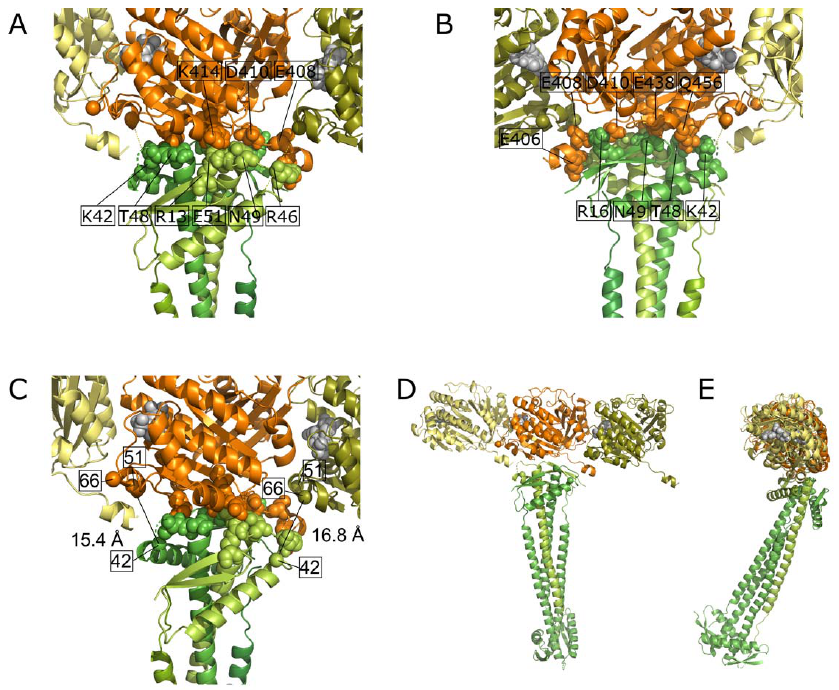
Figure 7. Haddock model of the interaction between a FtsZ filament and the ZapA tetramer. ( A ) and ( B ). Front and back side view of a closeup of the interaction site with the interacting amino acid residues of both proteins indicated. ( C ) Distances between the C α atoms (spheres) of residue K42 of ZapA and residues K51 and K66 of FtsZ that were found to cross-link. ( D ) Front and side view of the interacting proteins. ( E ) Frontal overview of a FtsZ filament consisting of three monomers and the interacting ZapA tetramer. ( D ) Side view of the same molecules with a second FtsZ filament and the cytoplasmic membrane indicated. The grey spheres at the interface of the FtsZ monomers is GTP.